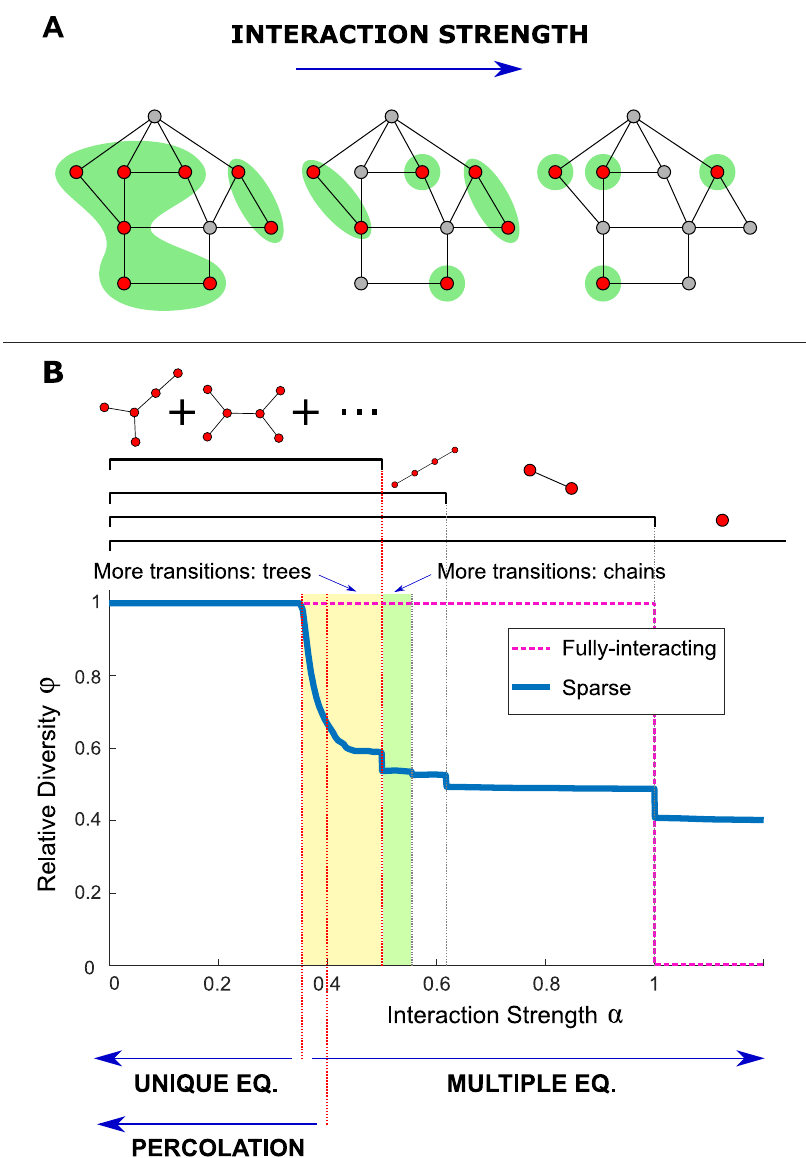
Fig 1. Transitions in community structure. (A) Equilibria reached at different interaction strengths. Red vertices represent persistent species, gray extinct species, and edges mark pairs of interacting species. The persistent species can be divided into connected subgraphs, shown with green background, separated by the extinct species. As the interaction strength α is increased, there are fewer and typically smaller allowed subgraphs, reducing the number of coexisting species. (B) The relative diversity ϕ = S � / S (where S � is the number of persistent species) at equilibrium, from simulations with pool size S = 400 and sparse interactions with degree C = 3 (blue); and for comparison for a fully-interacting community (pink, dashed), which exhibits only a single jump at α = 1. The sparse case exhibits infinitely-many sharp transitions, some of which are marked by dashed vertical lines. By order of increasing α , the first ffiffi transition is at a ¼ 1 p , from a unique to multiple equilibria. Next there is a percolation transition at α perc � 0.41, UE 2 2 below which a finite fraction of the persistent species belong to a single giant connected component. Above this value are seen several jumps. These result from changes in the allowed connected subgraphs, specifically those that are trees. At a ð1Þ ¼ 1 trees more complicated than a linear chain stop being allowed; there are three more visible jumps chain 2 corresponding to the ruling out of the length 6, 4, and 2 chains, with other similar jumps that are too small to be seen by eye (green region). There are also many jumps associated with trees that are not chains (yellow